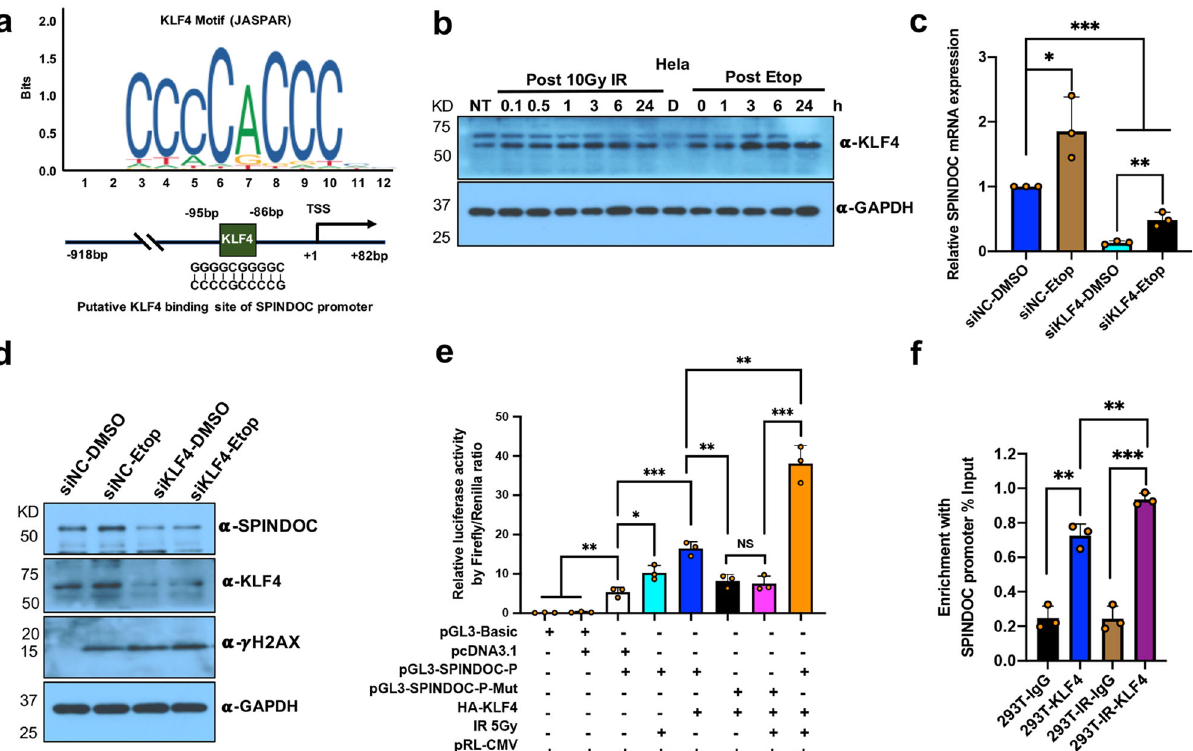
Fig. 5 DSBs promote SPINDOC transcription by KLF4. a Schematic showing the optimal KLF-binding motif from JASPAR website and the position of this KLF4-binding site in human SPINDOC promoter. b Hela cells were treated with 10-Gy IR and 40 μ M Etoposide for one hour before media replacement, and then incubated for the indicated timepoints and analyzed for anti-KLF4 expression by Western blot. The data are representatives of three independent experiments. c Hela cells were transfected with siNC or siKLF4 for 48 h and then treated with 40 μ M Etoposide or DMSO for one hour before